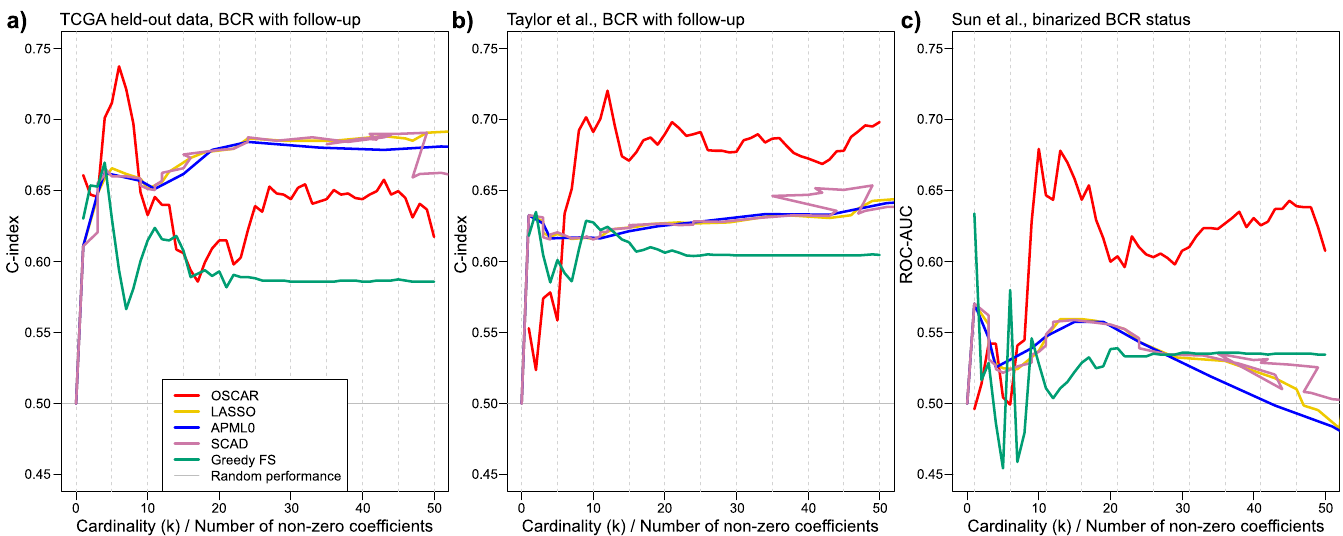
Fig 9. Performance in the high-dimensional transcriptomics data based on model fitting on the TCGA training data. Shrinkage based methods (LASSO, APM- L 0 , and SCAD) were plotted as a function of λ ; of these, SCAD was the only method for which the number of incorporated features appeared as a non-monotonous function of λ . a) One fourth of the TCGA data ( n = 101) was left out as a held-out validation dataset. b) Taylor et al. ( n = 131) with biochemical recurrence with follow-up times was used as an independent validation dataset. c) Sun et al. ( n = 79) with binarized biochemical recurrence without follow-up times was used as an independent validation